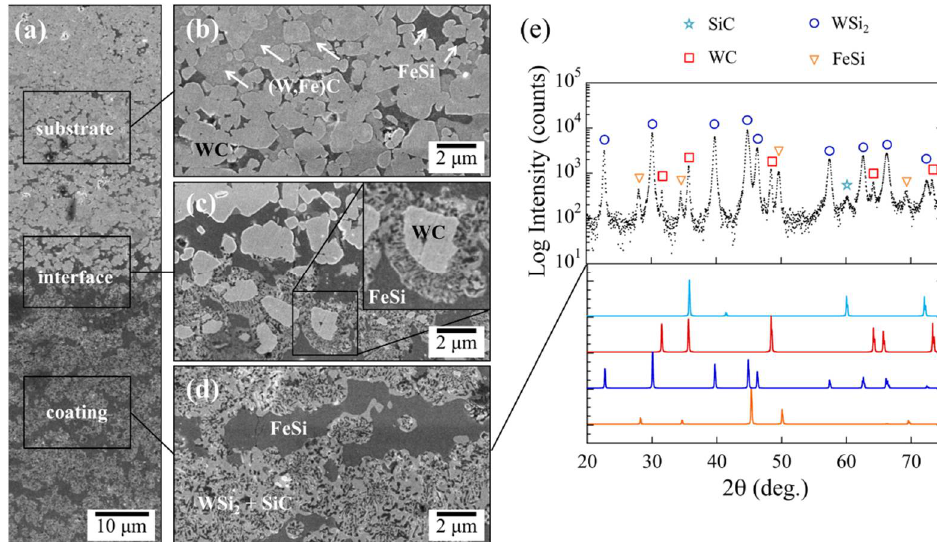
Figure 7. ( a ) Overview SEM image and ( b – d ) magnified SEM images of coating. Inset of part ( c ) a WC particle in the process of reacting with FeSi to form a WSi 2 (light contrast) and SiC (dark). Corresponding XRD spectra from ( d ) is shown in ( e